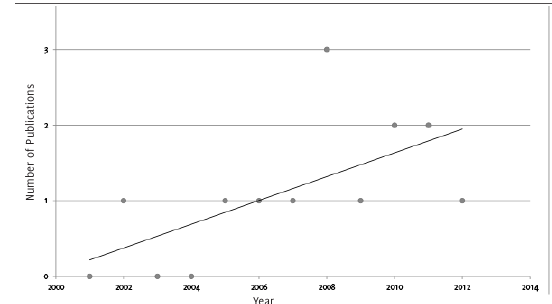
Figure 2. Number of Bibliometric Publications Published in CIMEL between 2001 and 2012